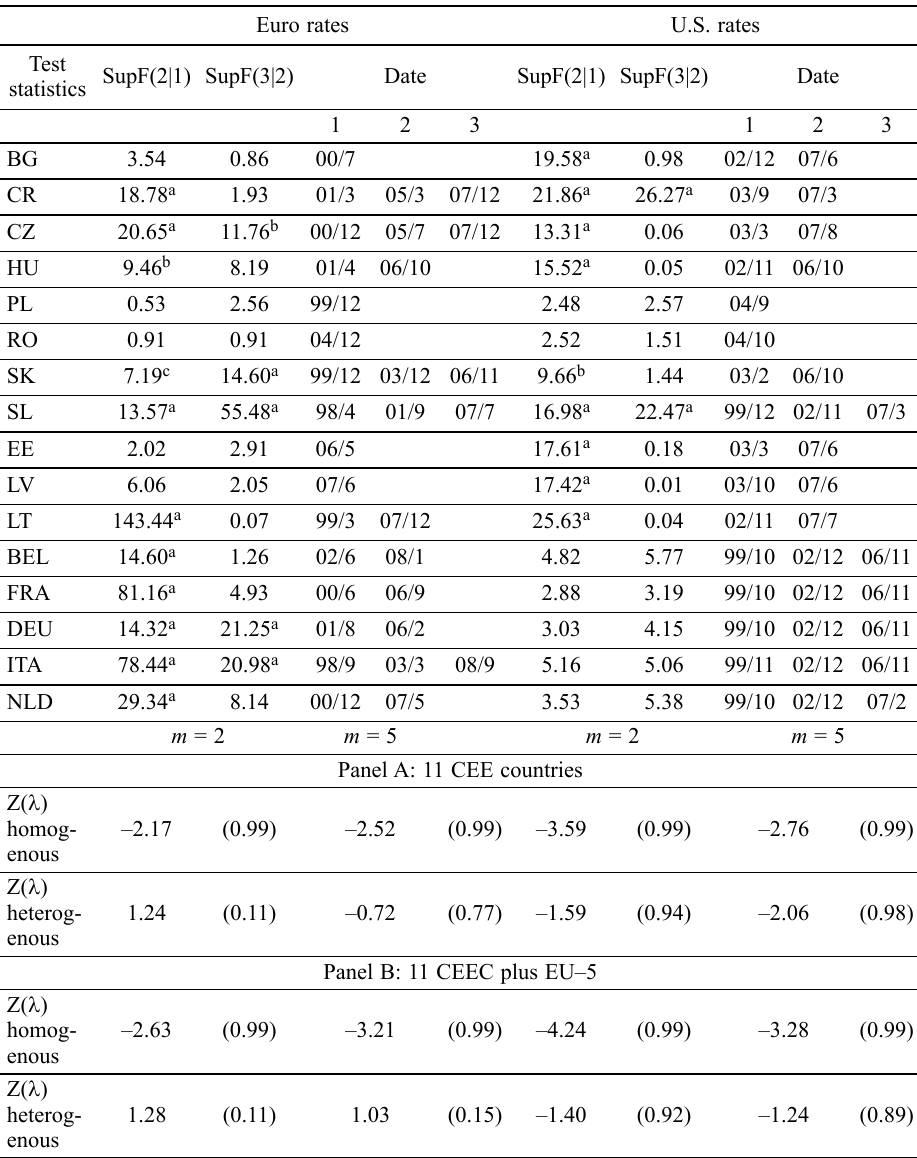
Table 1. Panel stationarity test with multiple breaks Euro rates U.S.